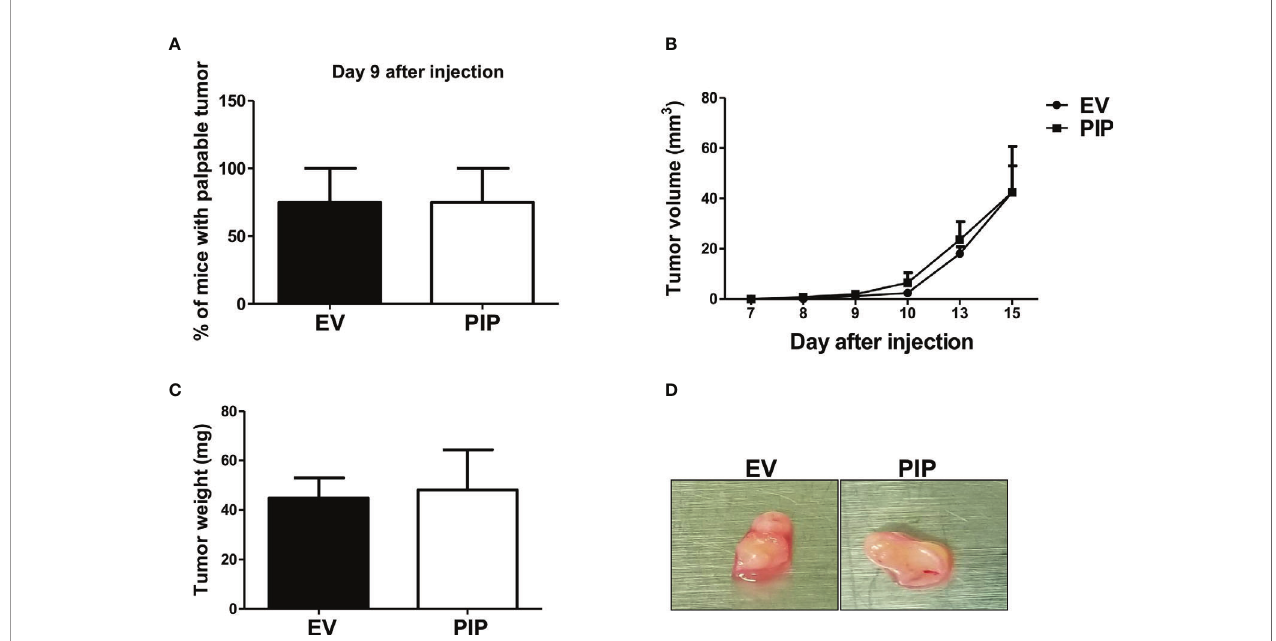
FIGURE 5 | Delayed onset and reduced tumor growth by 4T1-PIP cells is abrogated in immunode fi cient mice. PIP expressing 4T1 tumors (PIP) and empty vector controls (EV) were injected into Rag2 − / − g c − / − double knockout (DKO) BALB/c mice and onset of palpable tumor (latency) was determined (A) . The tumor growth was measured with digital calipers (B) . At sacri fi ce, the tumors were excised, and the weight was determined (C) . A representative photo image of the excised tumors is shown (D) . Results are representative of two different experiments. Results are expressed as mean ± SEM of n = 4 mice/group, T-test and two-way ANOVA were conducted.